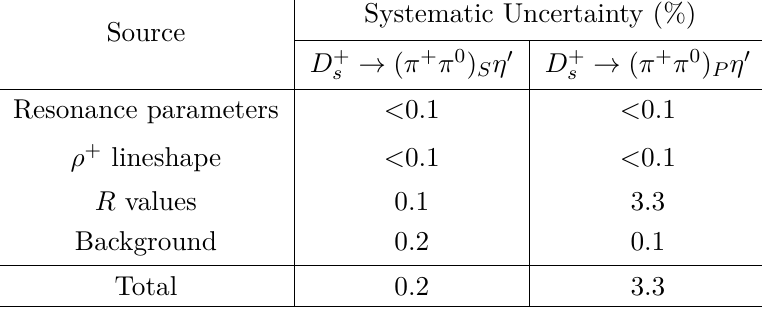
Table 5 . Systematic uncertainties on FFs for S -wave and P -wave nonresonant